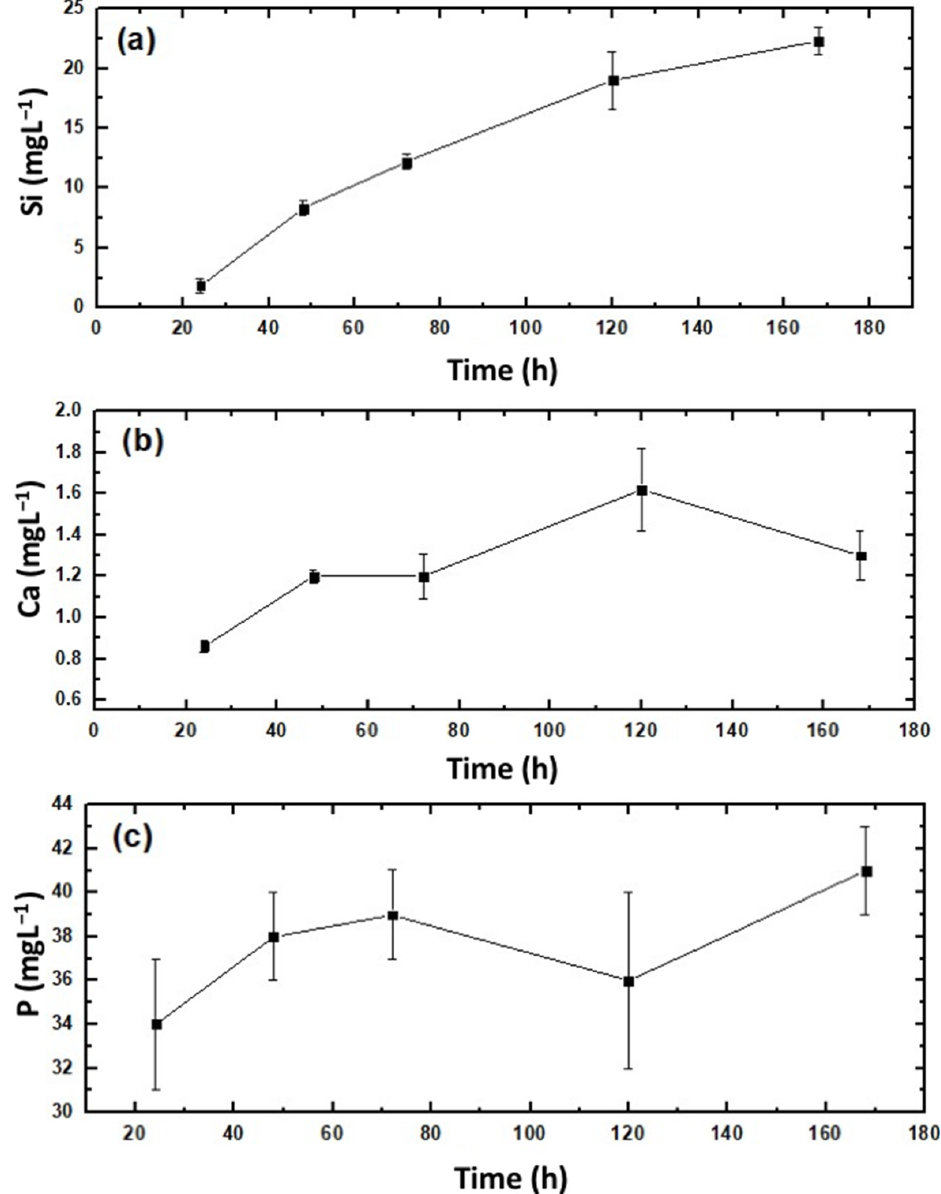
Figure 7. Profiles of cumulative ion release of ( a ) Si; ( b ) Ca; ( c ) P from the hydrolytic degradation of the SG40TCP60 material after immersion in PBS for 1 week. Both free Ca- and P-plotted concen- trations were obtained by subtracting the initial Ca and P concentrations of PBS from the ICP_MS measurements after different immersion periods.